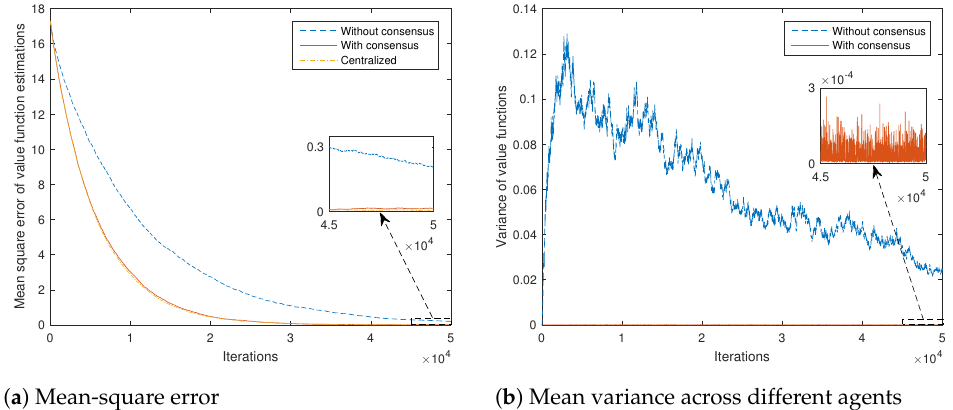
Figure 3. Error statistics of state-value function estimations for different algorithms, versus number of iterations.